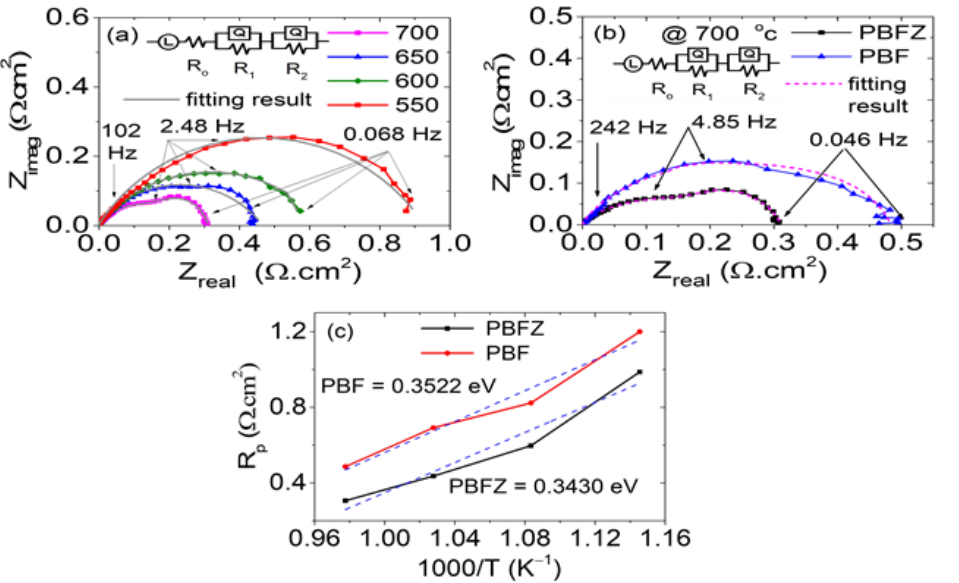
Figure 4. Nyquist plots of the symmetric cell ( a ) PBFZ|SDC|PBFZ, ( b ) PBFZ|SDC|PBFZ and PBF|SDC|PBF at 700 °C, ( c ) R p values for PBFZ and PBF cathode from Arrhenius plots. PBF|SDC|PBF at 700 ◦ C, ( c ) R p values for PBFZ and PBF cathode from Arrhenius